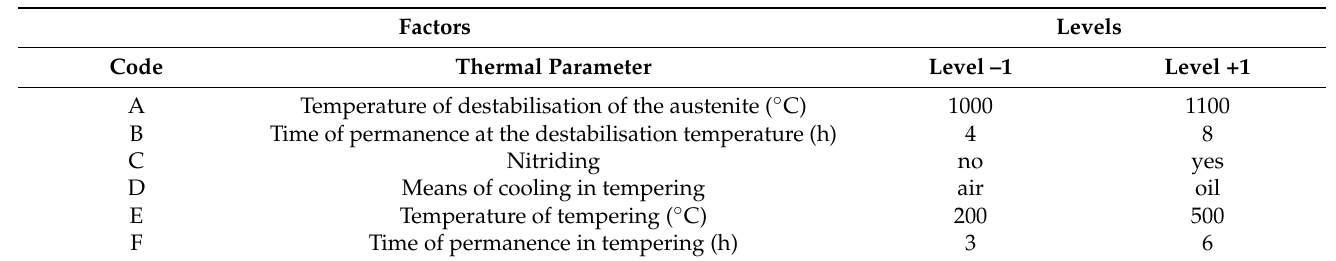
Table 2. Factors and levels.